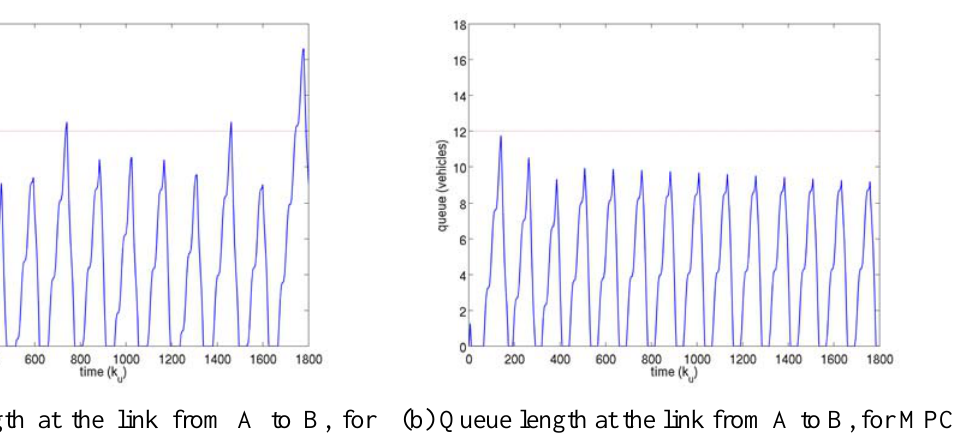
Figure 9. The effect of a queue length constraint